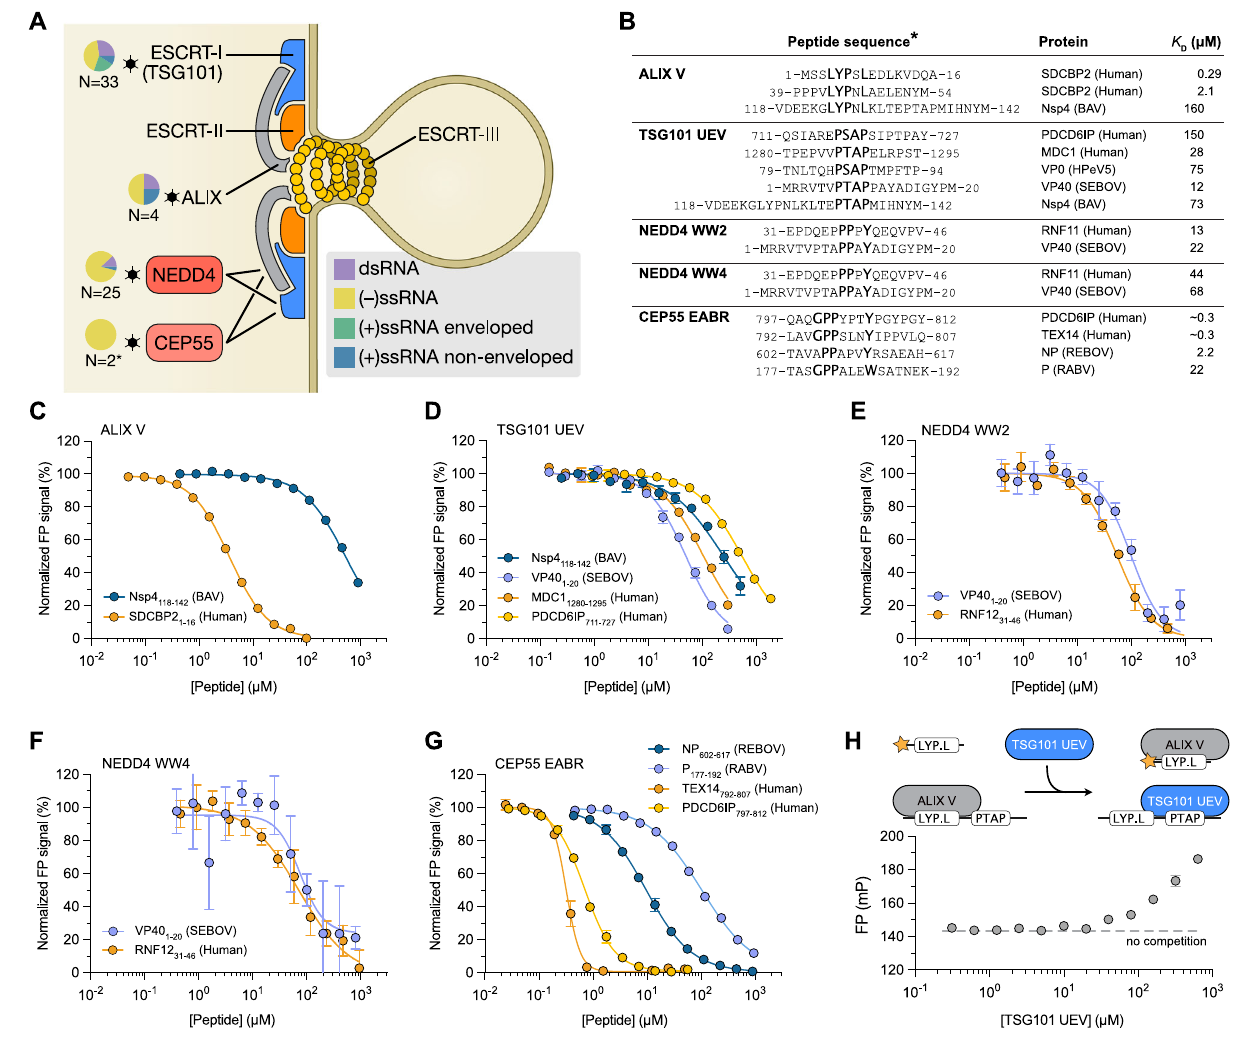
Fig. 3 | The ESCRT machinery is hijacked by viral SLiMs that bind to NEDD4 WW,TSG101 UEVand ALIXV,and potentiallyalsotoCEP55EABR.A Schematic representation of the ESCRT pathway leading to reverse topology budding. Pie charts next to each target show the class of viral species hijacking it. N represents the number of identi fi ed interactions. B Overview of the peptides that bind to ESCRT pathway proteins for whichaf fi nitiesweremeasured.Residuesconstituting the recognition motif are shown in bold. C – G FP-monitored displacement experi- ments of viral and human peptides and ESCRT proteins. All